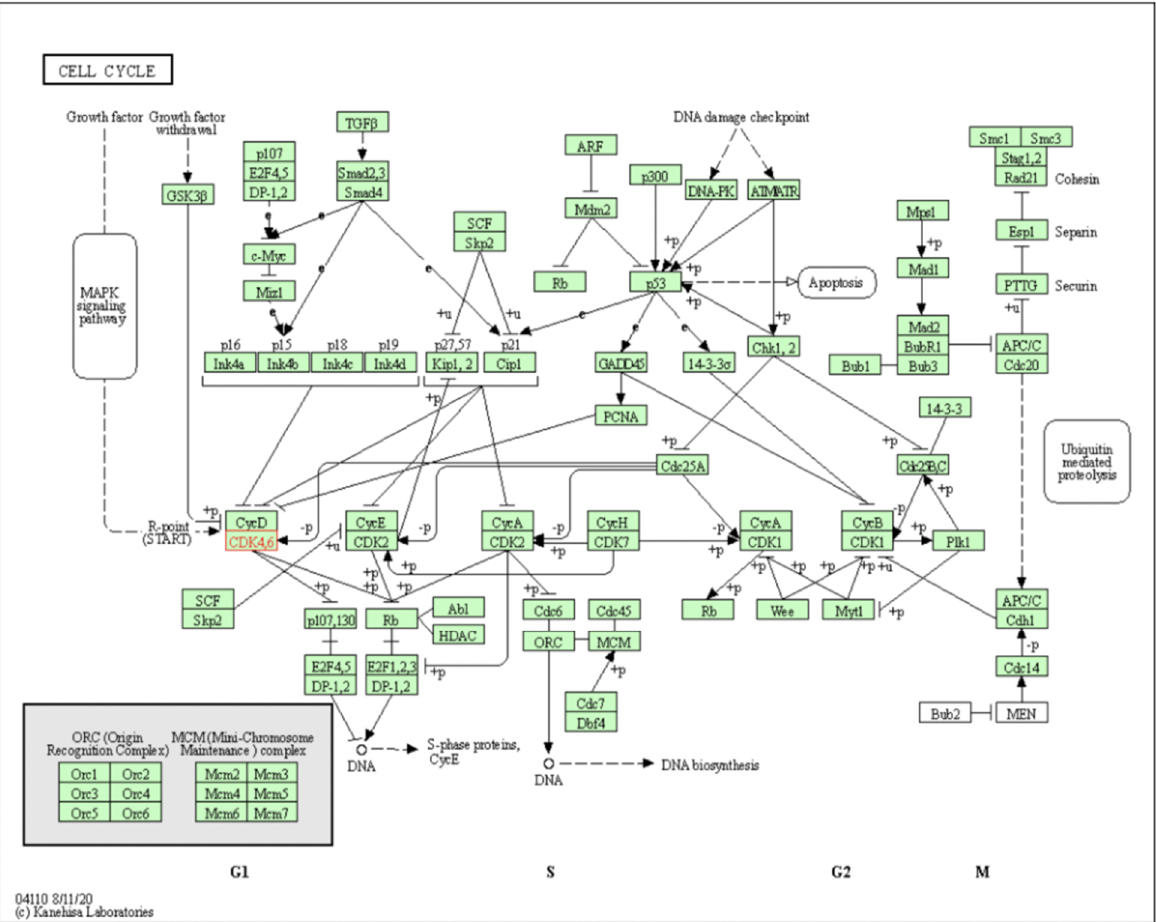
Figure 8. Pathway map showing the mitotic cell cycle progression, through the events of DNA replication (S phase) and mitosis (M phase), separated temporally by the G1 and G2 phases. Cyclin-dependent kinases (CDKs), activated by specific cyclins to form CDK/cyclin-complexes, modulate the activity of key substrates to regulate the cell’s progression through the cell cycle phases. Cyclin-CDK inhibitors (CKIs), including p16 INK4a , p15 INK4a , p27 Kip1 and p21 Cip1 contribute to the negative regulation of CDK activities. CDK4/6 (the focus of this study) is shown in red. Image taken from: KEGG PATHWAY database (Kyoto, Japan) [25]. Accession number: map04110.